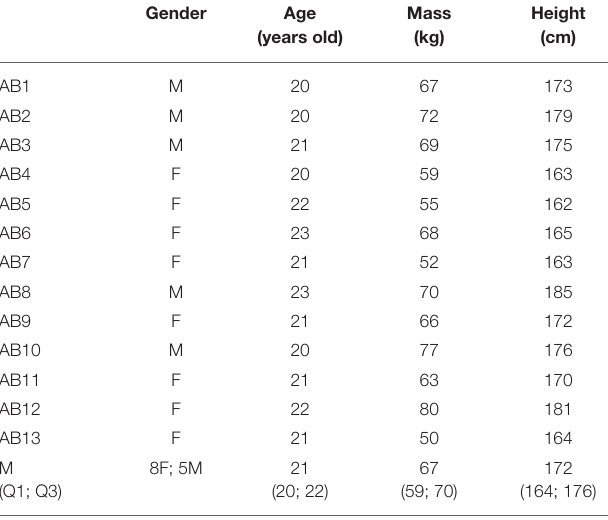
TABLE 1 | Individual anthropometric characteristics: gender, age, mass, and height.